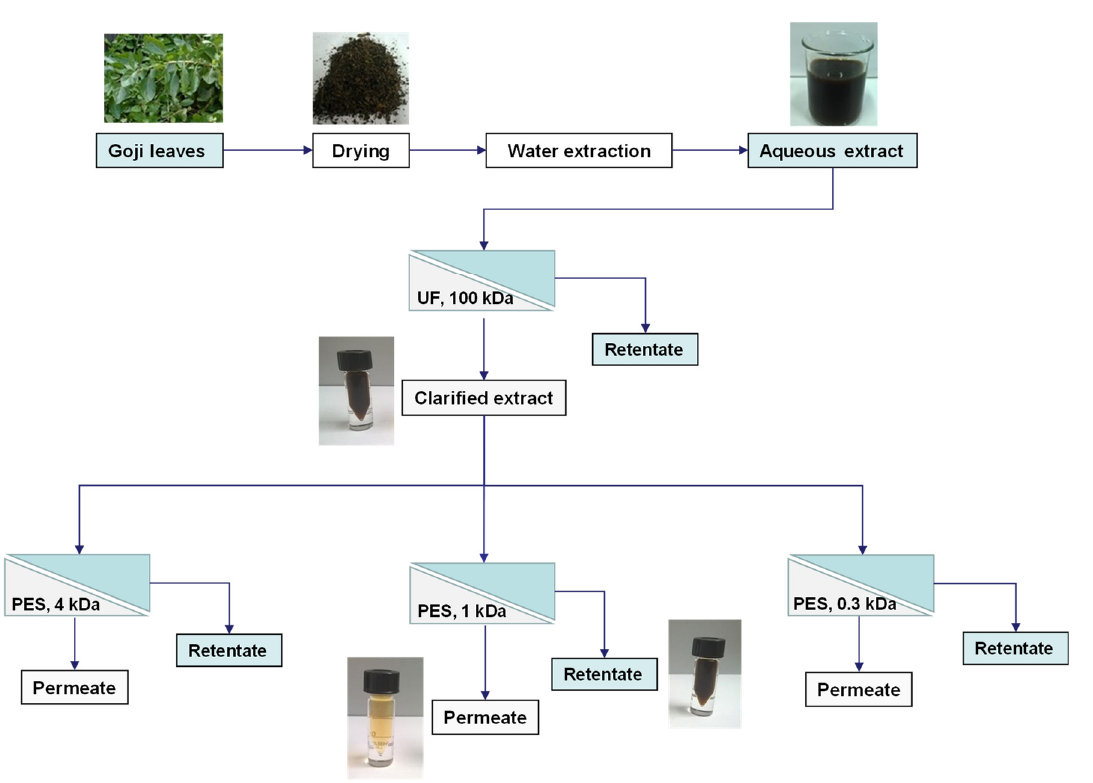
Figure 1. Schematic representation of the experimental design (PES,